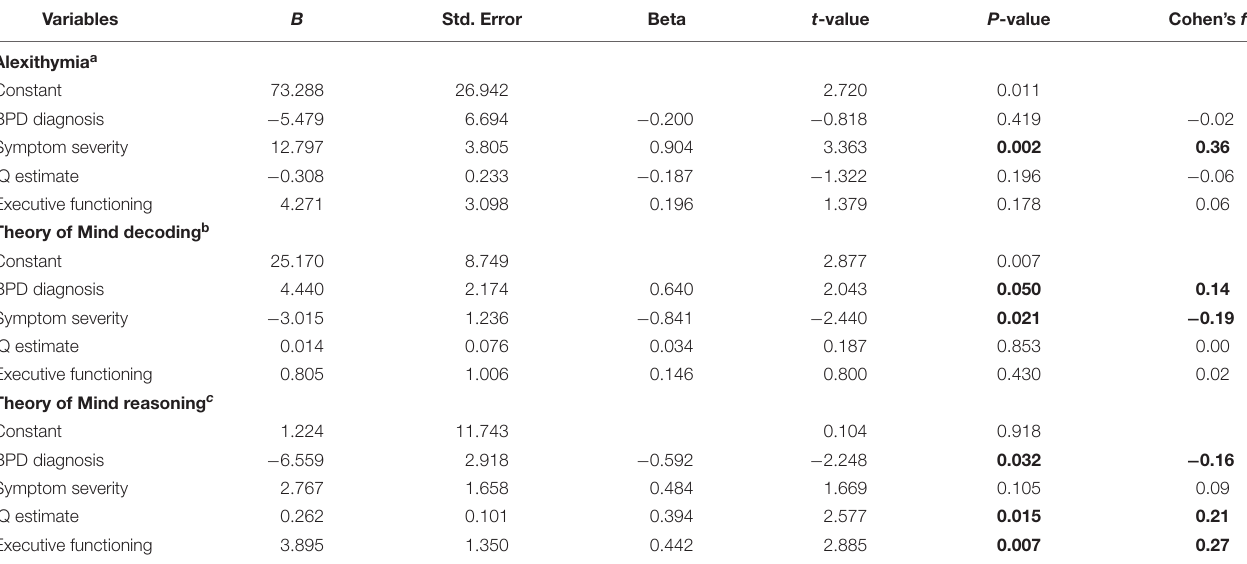
Group means and between-group comparisons. BPD, borderline personality disorder; HC, healthy controls; WCST, Wisconsin Card Sorting Test; LST, Listening Span Task; FT, Flanker Task; LFT, Letter Fluency Task; TAS-20, Toronto Alexithymia Scale-20 items; RMET, Reading the Mind in the Eyes Test; FPT; Faux Pas Test; SD, standard deviation. a Higher scores indicate worse functioning. Statistically significant results are presented in bold. *Significant after Bonferroni correction. Cohen’s d values of 0.2, 0.5, and 0.8 represent small, medium, and large effect sizes, respectively. TABLE 3 | Multiple regression models for mentalizing